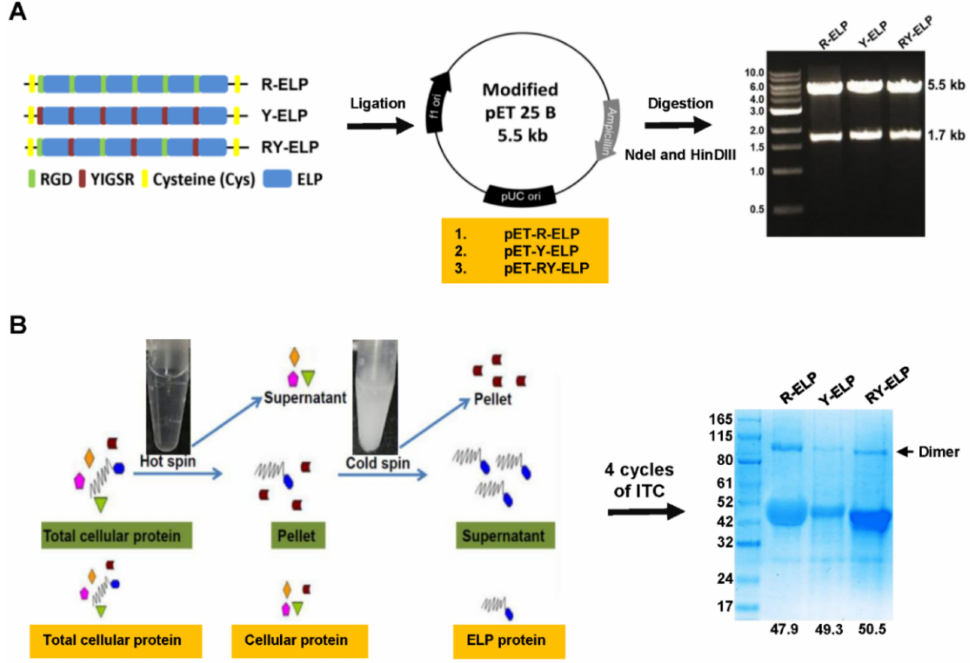
Figure 1. Expression and purification of ELP derivatives. ( A ) Schematical representation of R-ELP, Y-ELP, and RY-ELP ligation into pET 25 b+ after linearization with SfiI enzyme. Similarly, all the fusion ELP (R-ELP, Y-ELP) was ligated into pET 25 b+ vector for protein expression. Proper ligation of fusion ELPs in the vector was confirmed by double digestion with Nde I and Hind III (right). Size of the DNA fragments after digestion was indicated on the right. ( B ) All the fusion ELPs were purified by triggering phase transition at room temperature by adding NaCl. Repeated cycle of hot spin to aggregated protein and cold spin to dissolve ELP pellet was continued for four rounds to obtain fusion ELPs from cell lysate to homogeneity. The purity of fusion ELPs were confirmed through SDS-PAGE analysis (on right). The molecular weight fusion ELPs were indicated below